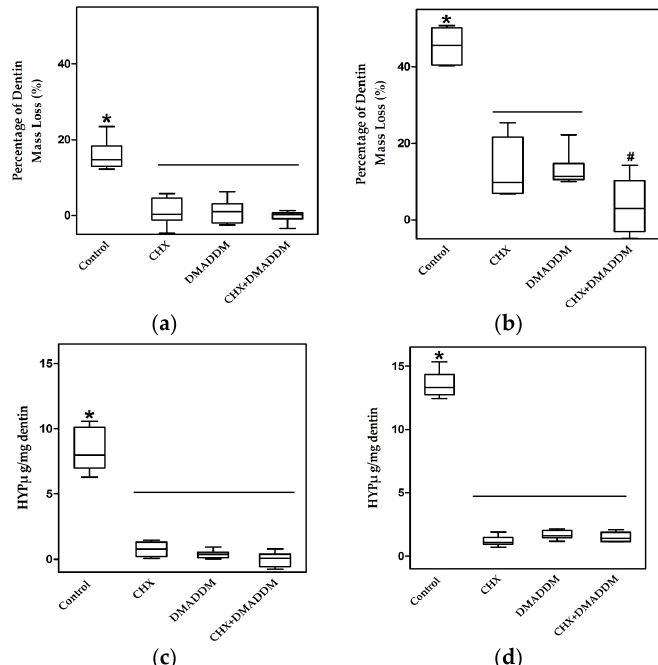
Figure 2. Dentin beams proteolytic degradation assay. The percentage of dry mass loss after: ( a ) 7 d ( n = 6); and ( b ) 30 d. The amount of dissolved collagen from demineralized dentin beams after: ( c ) 7 d; and ( d ) 30 d ( n = 6). The Y-axis represents the measured mass ( μ g) of dissolved hydroxyproline at 7 or 30 d/dentin dry mass (mg) at 0 d. The asterisk represents statistically significant differences; * p < 0.05.